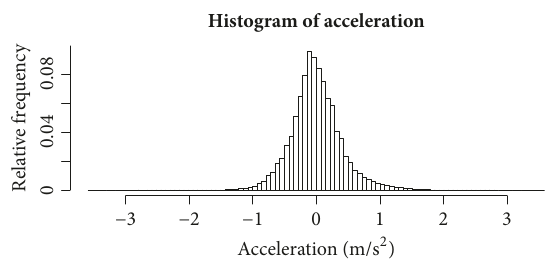
Figure 9: Example of a normal